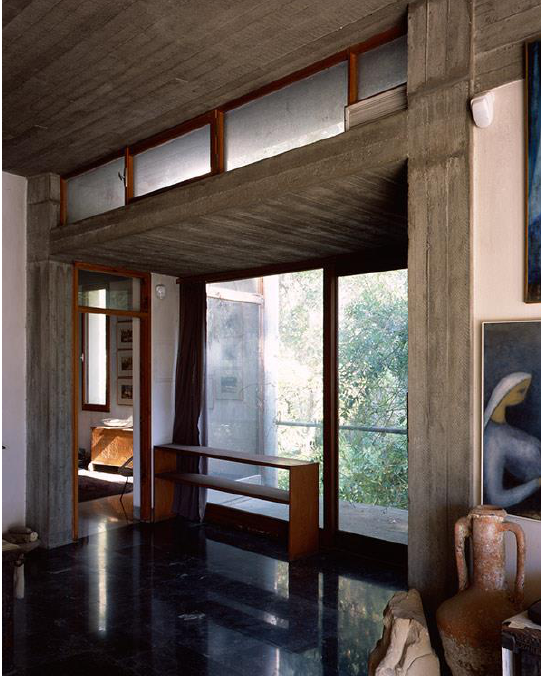
Figure 12. Neoptolemos and Maria residence 1964.